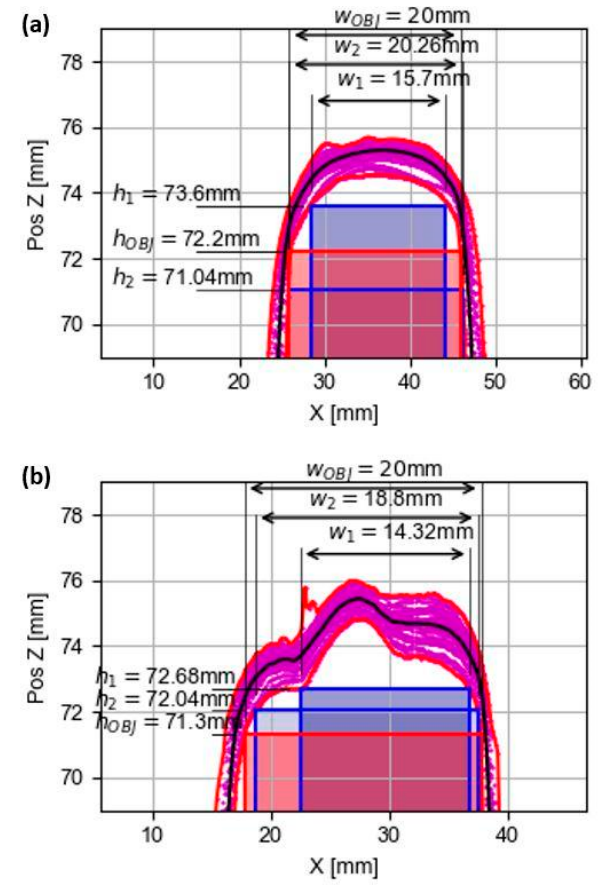
Figure 15. Calculation of the effective cross-sectional area of the wall manufactured by means of ( a ) oscillating strategy or ( b ) overlapping of linear welds strategy.